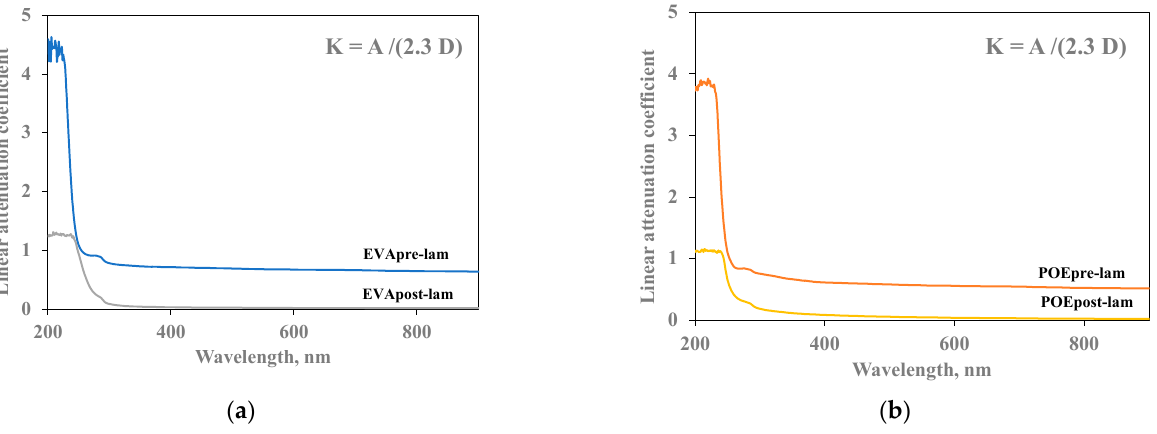
Figure 5. Linear attenuation coefficient (K) of ( a ) EVApre-lam and EVApost-lam and ( b ) POEpre-lam and POEpost-lam commercial samples.